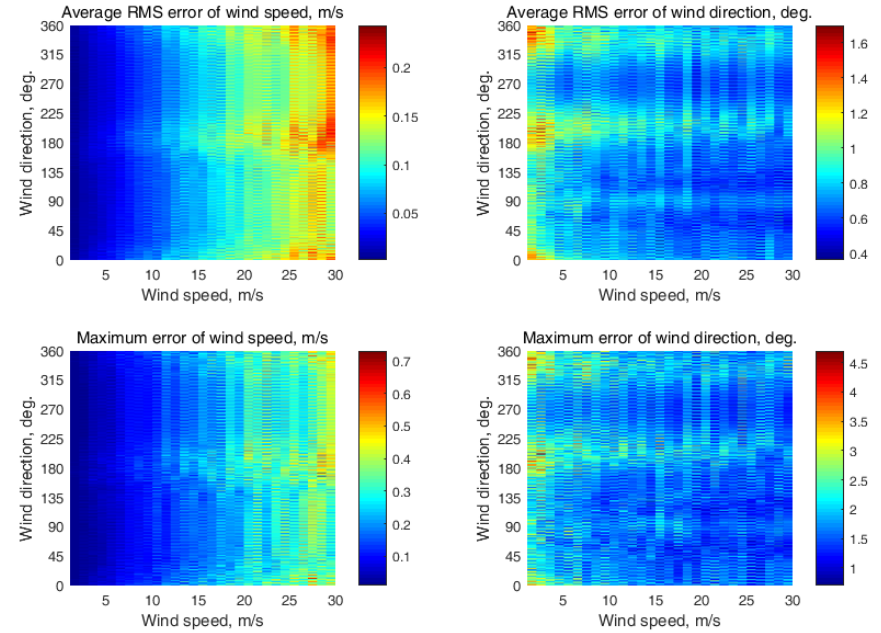
Figure A6. Semicircular wind retrieval results at a single 50° incidence angle.